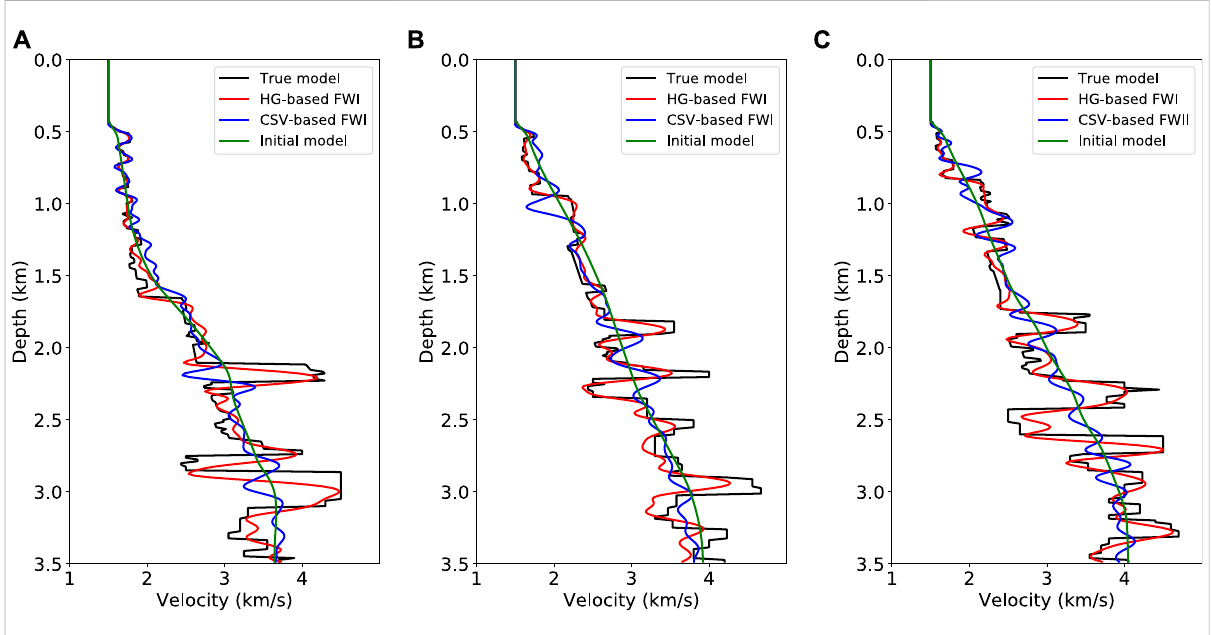
FIGURE 11 ComparisonsofvelocitylogsforMarmousimodel. (A – C) arelocatedatthemidpoints of1.8,5.0,and8.1 km,respectively. Blackandgreen lines arefromtrueandinitialmodels;blueandredlinesarefromCSV-basedFWIandtheproposedmethod.Theproposedmethodismuchmoreaccurate than CSV-based FWI for recovering deep low-wavenumber velocity